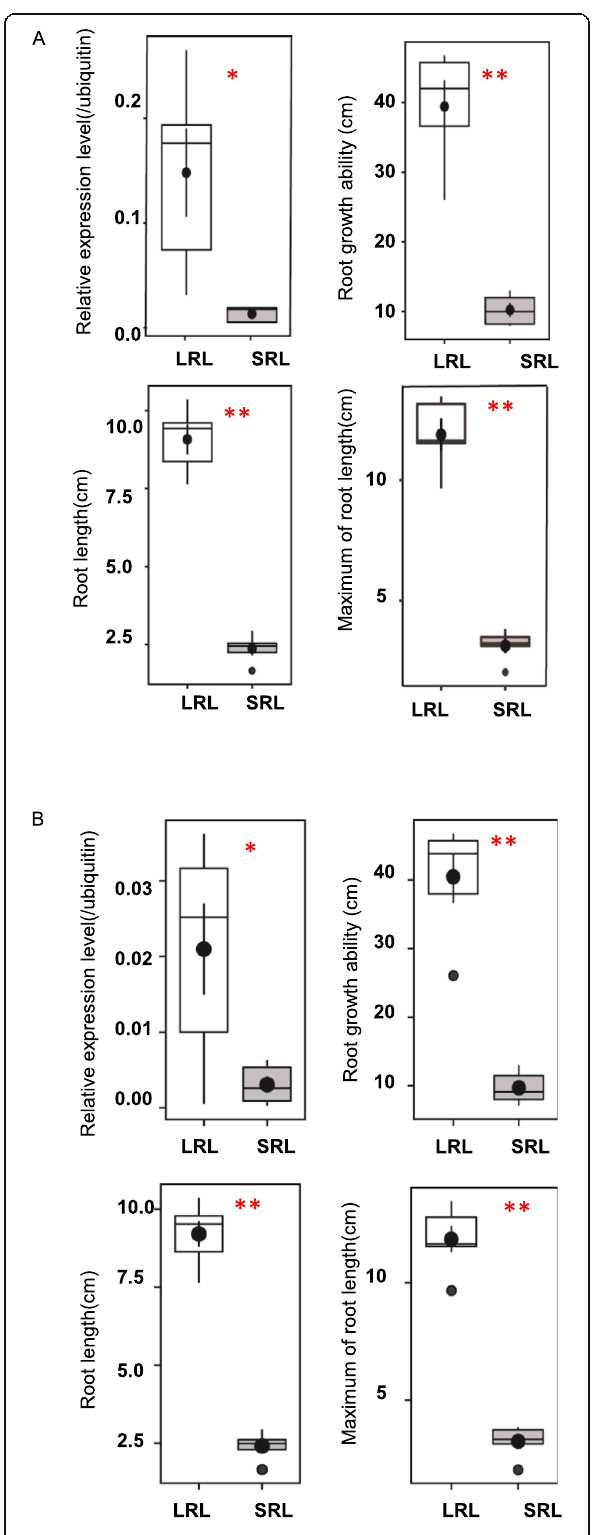
Fig. 6 Comparison of the relative expression level of candidate genes between groups with contrasting phenotypes in qRL-4. a Boxplots of relative expression level, RN, MRL, and RGA in different groups with contrasting phenotypes of LOC_Os04g09900 ( OsCyc1 ). LRL means varieties in the group with longer root length and SRL means the varieties in the group with shorter root length. Box edges represent the 0.25 and 0.75 quantiles with the median values shown by bold lines. Whiskers extend to data no more than 1.5 times the interquartile range and the remaining data are indicated by asterisks. “ * ” on the top of the boxplots represents the significance at 0.05 probability levels and “ ** “ represents the significance at 0.01 probability levels. b Boxplots of relative expression level, RN,